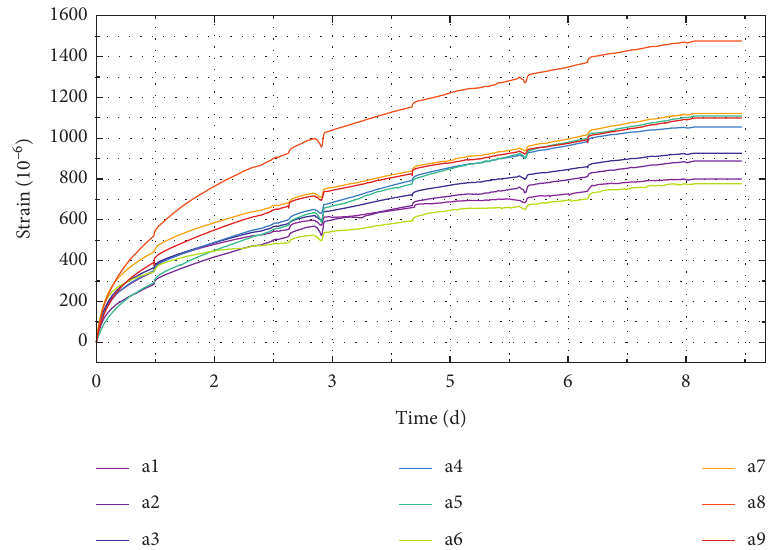
Figure 8: − 1879m core sample anelastic recovery strain curve.